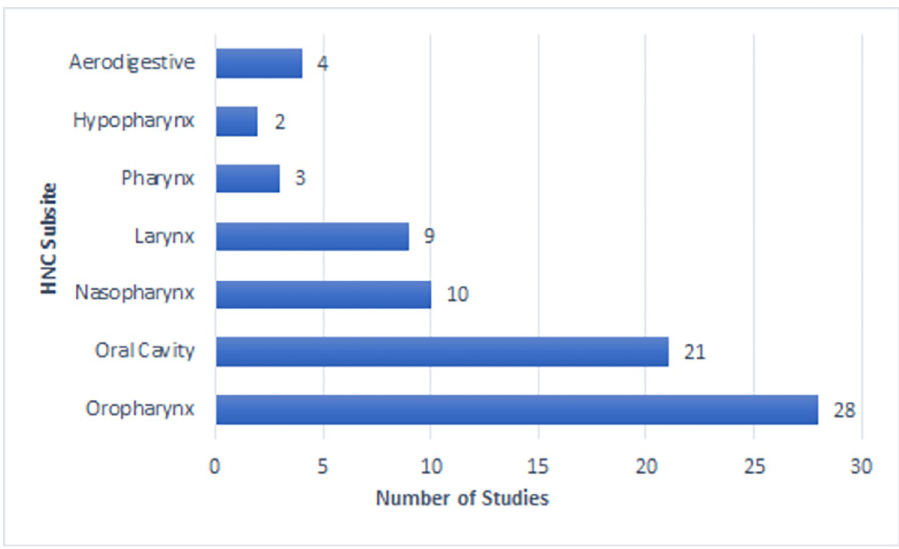
Fig 3. Participant details (tumour